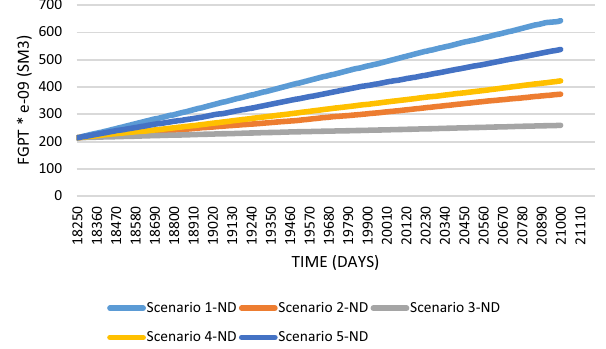
Fig. 6 Cumulative production of gas condensate in five natural deple- tion scenarios